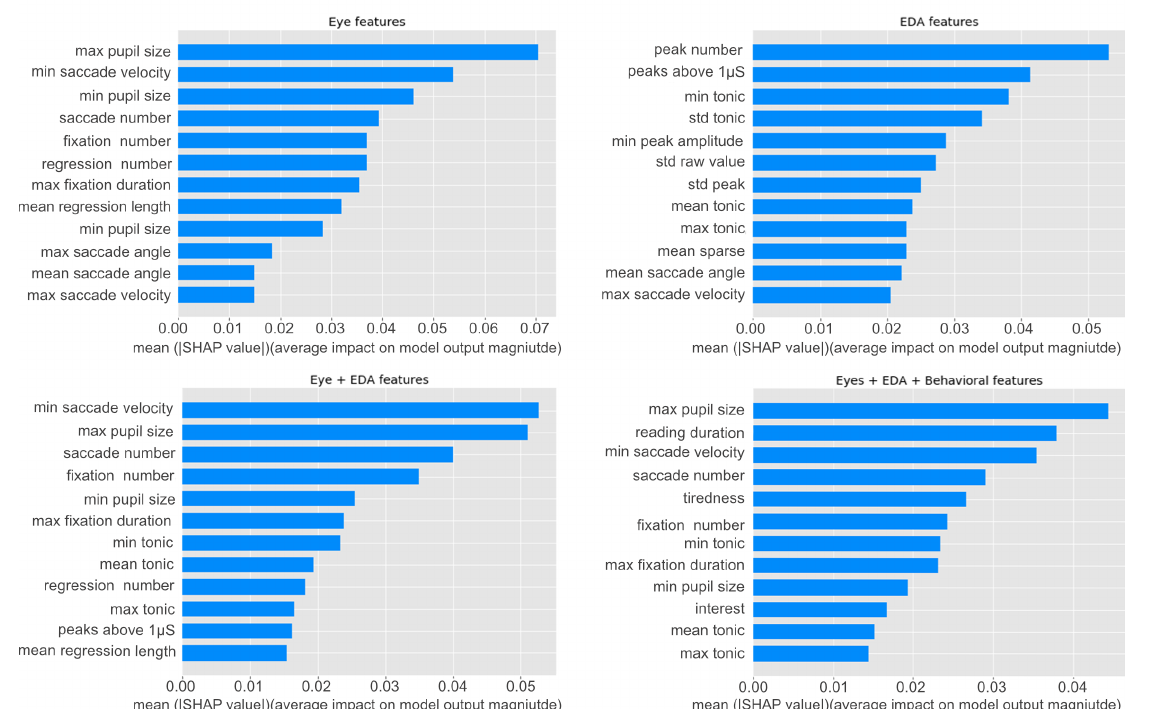
Figure 3. Feature importance graph for the Random Forest classification models usig the SHAP method. Top left : Eye-based model. Top right : EDA-based model. Bottom left : Eye and EDA-based model. Bottom right : Sensory and Behavior-based